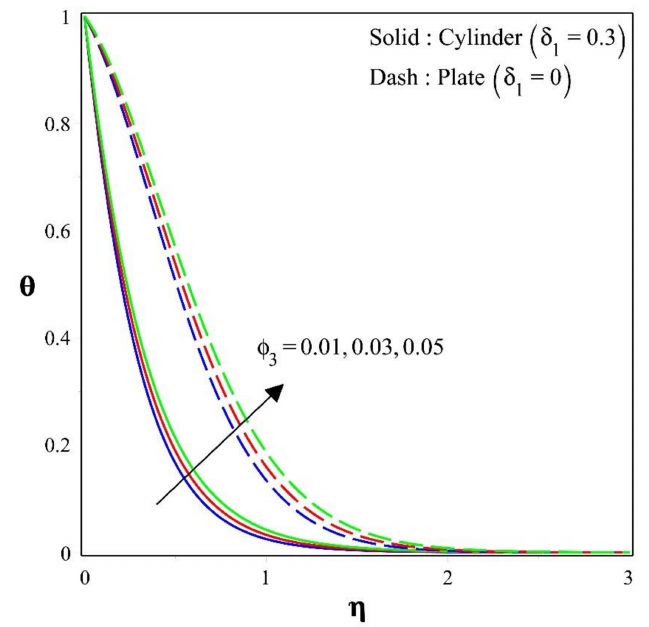
Figure 10. The role of solid volume fraction on temperature profile (keeping P m = γ 1 = 0.1, ζ = 30 0 , φ 1 = φ 2 = 0.01 & H SS = 0.5).